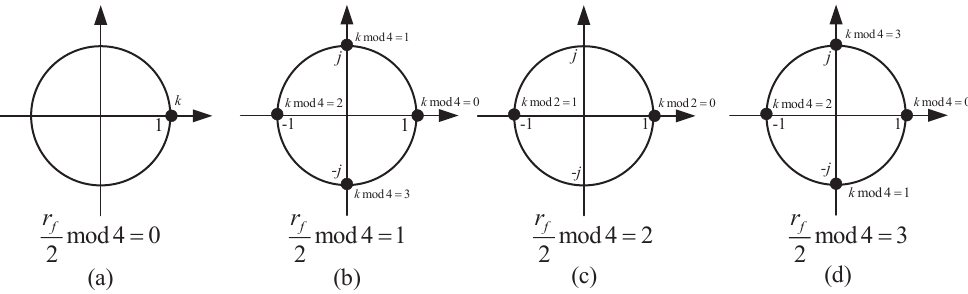
Figure 6. Diagram of generation of the four complementary sequences based on frame